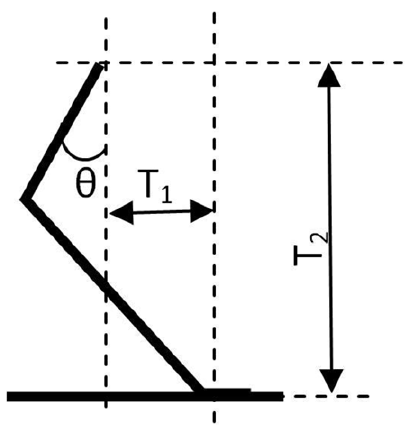
Figure 8. Moment arm from the most proximal point of humerus to the presumed vertical vector of the ground reaction force (GRF measured at FF).